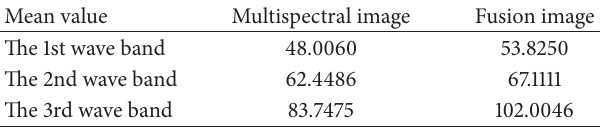
Table 2: Mean value of multispectral image and fusion image.